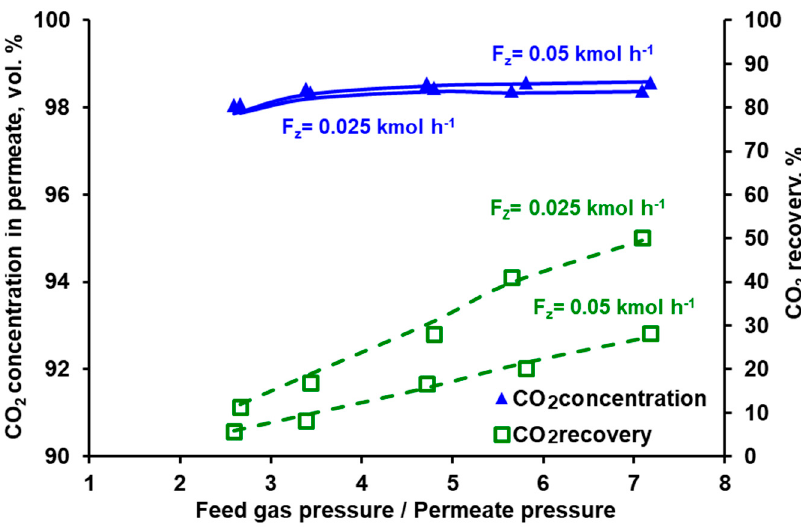
Figure 8. Experimental (points) and theoretical (lines) CO 2 purity and recovery in UBE UMS-A5 module against feed to permeate pressure ratio for various feed gas flow rates. Inlet CO 2 concentration: 70 vol.%, temperature: 295 K. Standard deviation; purity = ± 0.4, recovery = ± 0.1.